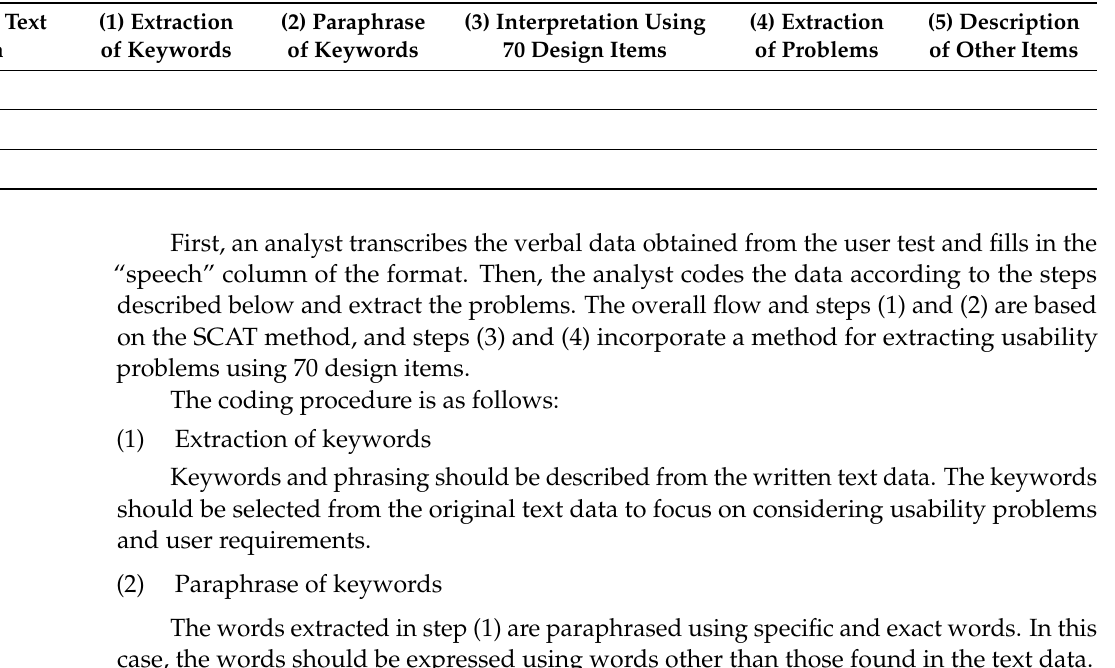
Table 1. Format of the